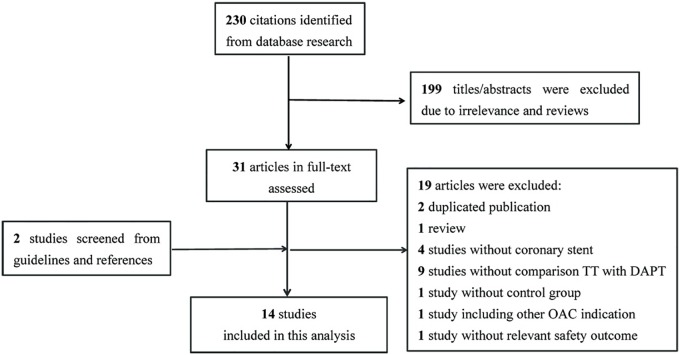
Flow diagram showing the process of study selection.